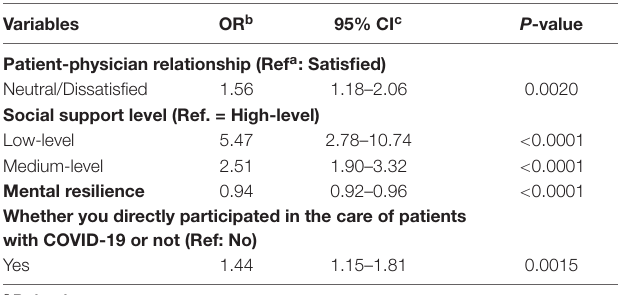
TABLE 4 | Multinomial logistic regression of factors associated with job burnout in medical